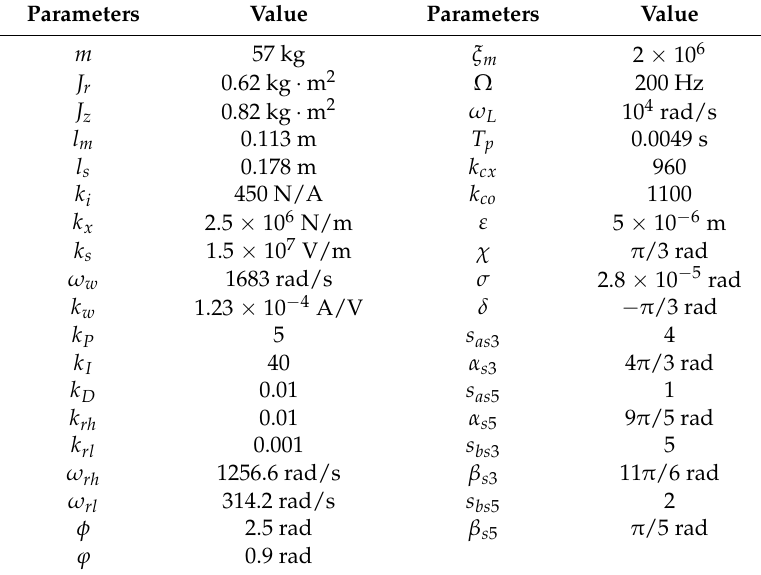
Table 1. Parameters of the AMB system with the proposed control approach. Parameters Value